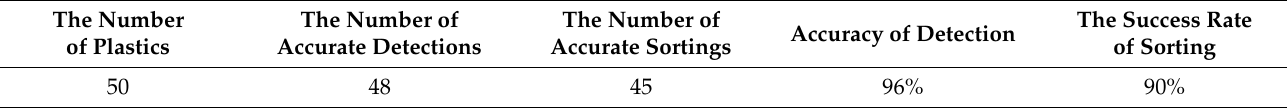
Figure 20. The grasping process of the robotic arm: ( a ) initial position; ( b ) move and rotate; ( c ) pick up the object; ( d ) transfer the object; ( e ) place the object; ( f ) back to initial position. Table 6. Test results of system